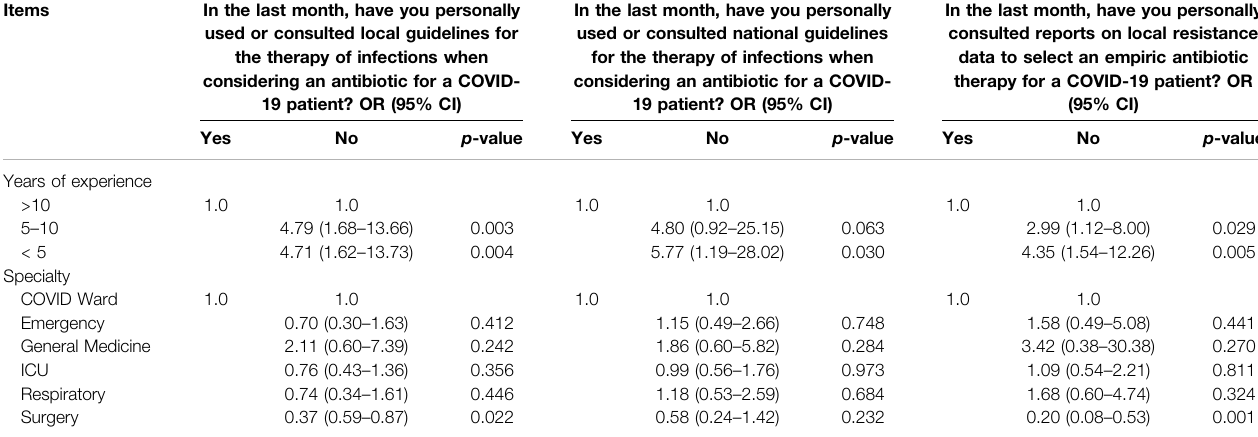
TABLE 5 | Logistic regression examining the association between years of experience and specialty with antibiotic prescribing process in COVID-19 patients.